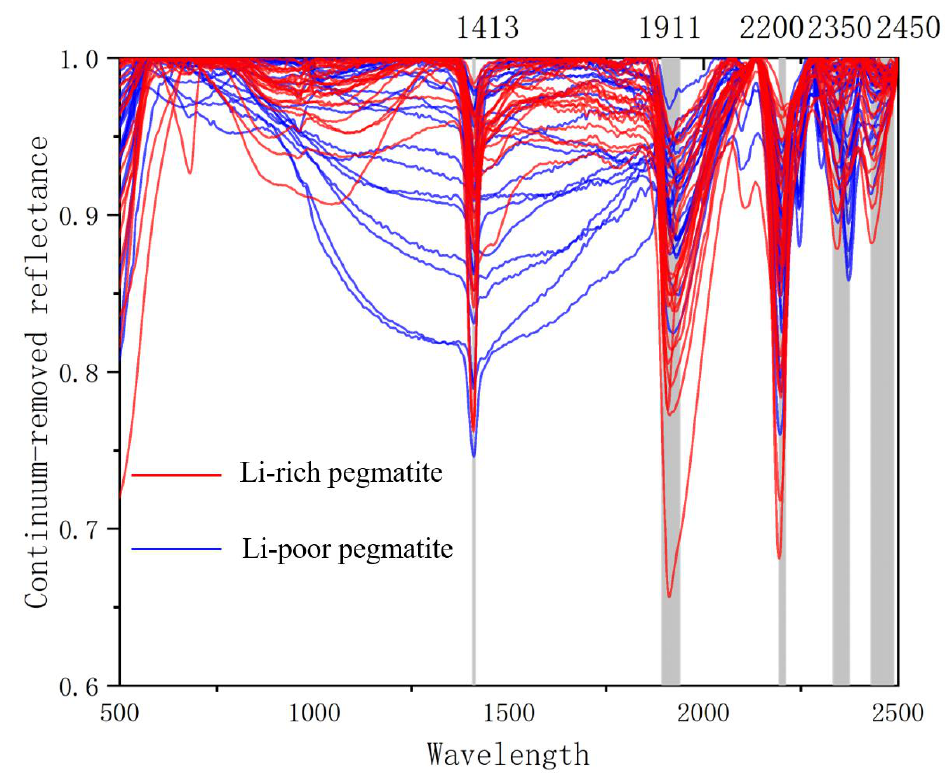
Figure 6. Spectral feature interval selection of the continuum removal spectra.